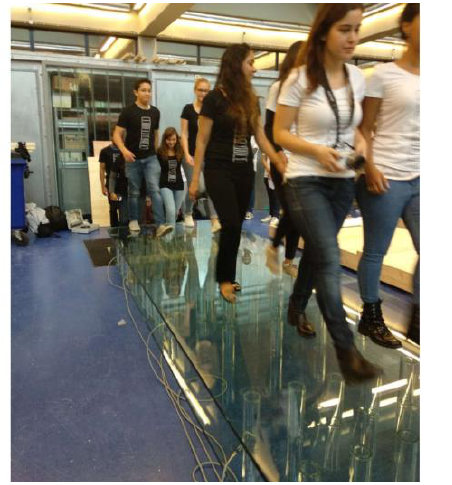
Fig. 13 Non-destructive test of large prototype panel using dynamic load.